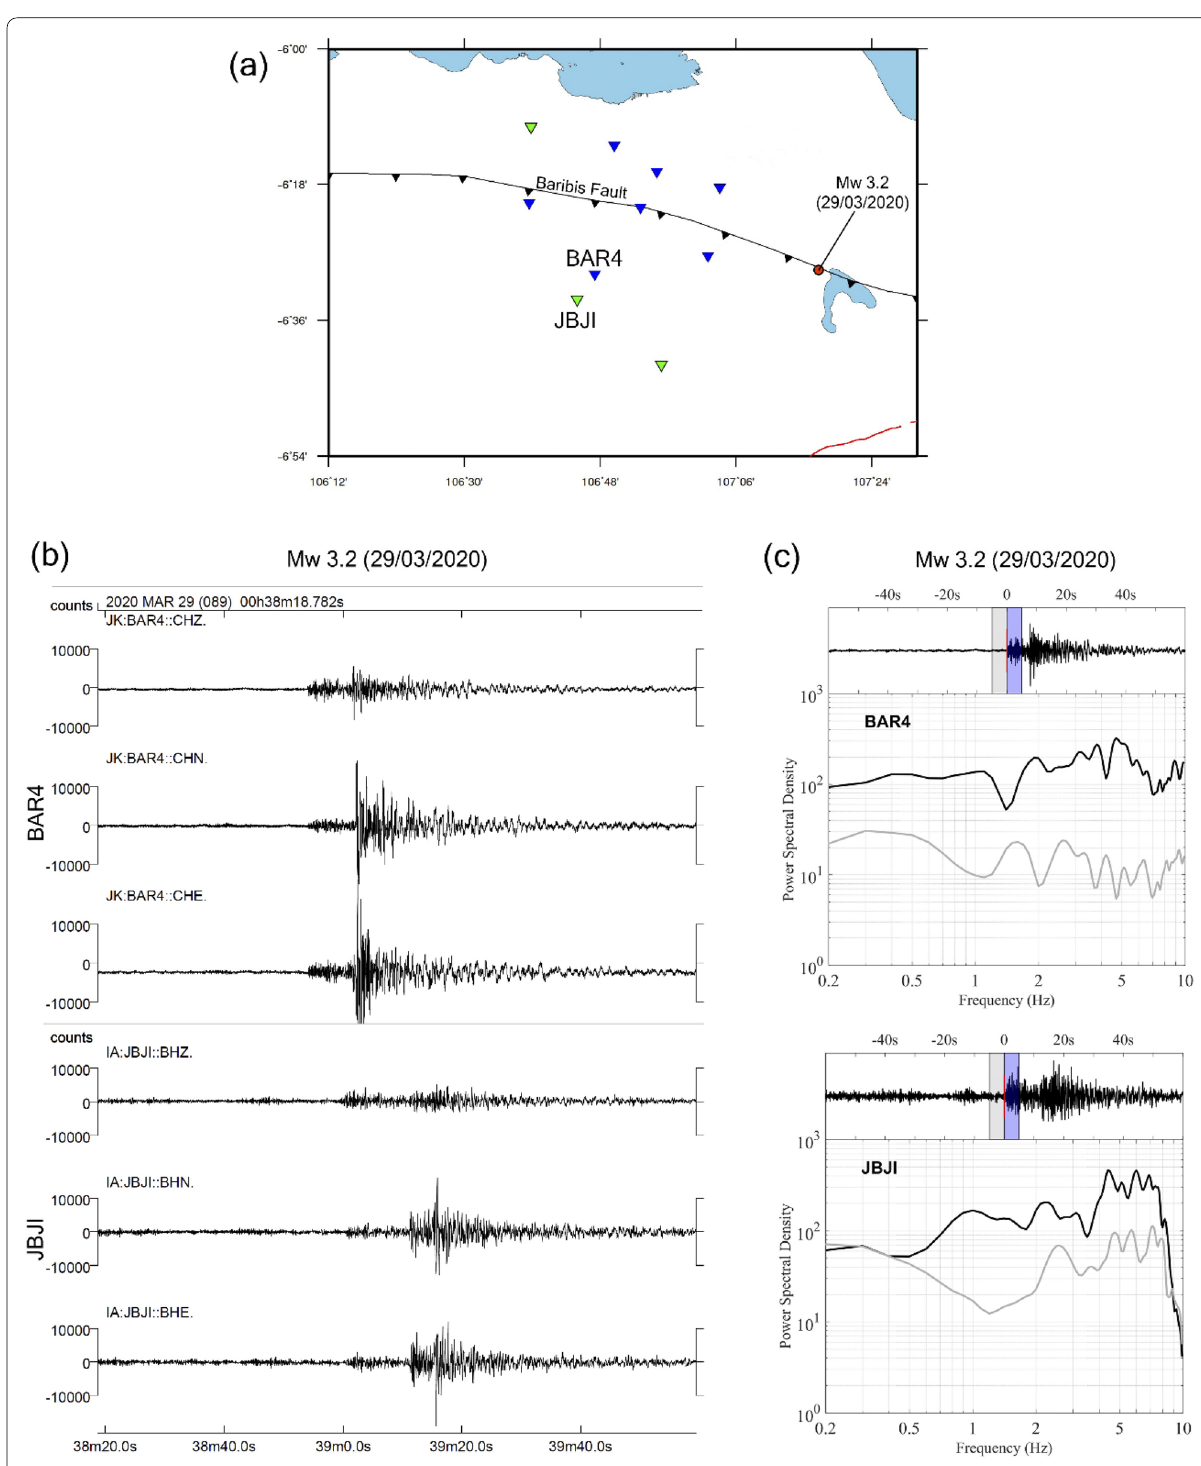
Fig. 4 a Map of event and stations used in the comparison of waveform and spectrum of an earthquake (Mw 3.2 on March 29, 2020) at adjacent BMKG (JBJI) and borehole (BAR4) stations. b The earthquake waveforms. c The corresponding spectrum. We show normalized time series of vertical component seismogram (top panel) and the evaluated signal and noise spectra (bottom panel). The window length used in the calculation of the noise and signal spectra are 5 s before and 5 s after the P-wave arrival time, respectively. In the top panel the signal window is represented as a blue shaded window, while noise is enclosed by a gray shaded window. In the spectrum panel, the gray curve represents the noise spectrum and the black curve is the signal